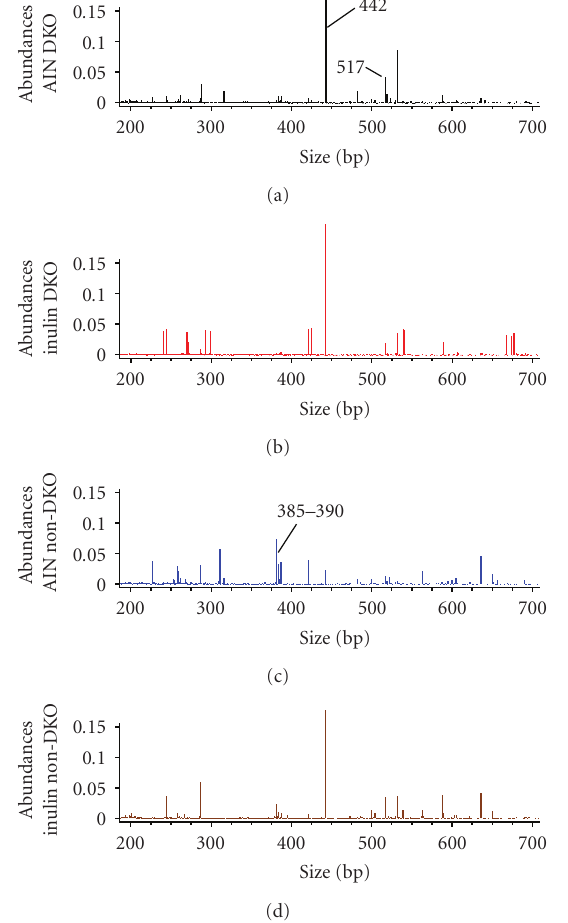
Figure 8: ARISA analysis of DNA from cecal contents of 129 N10. This DKO colony was established by backcrossing the mixed strain B6;129 colony to 129Sv/J for 10 generations. The group sizes are 21 DKO mice on AIN diet, 10 non-DKO mice on inulin- supplemented AIN diet, 7 non-DKO mice on AIN diet, and 15DKO mice on inulin-supplemented AIN diet. The non-DKO mice are heterozygous DKO with 2 or 3 WT alleles for combined Gpx1 and Gpx2 .